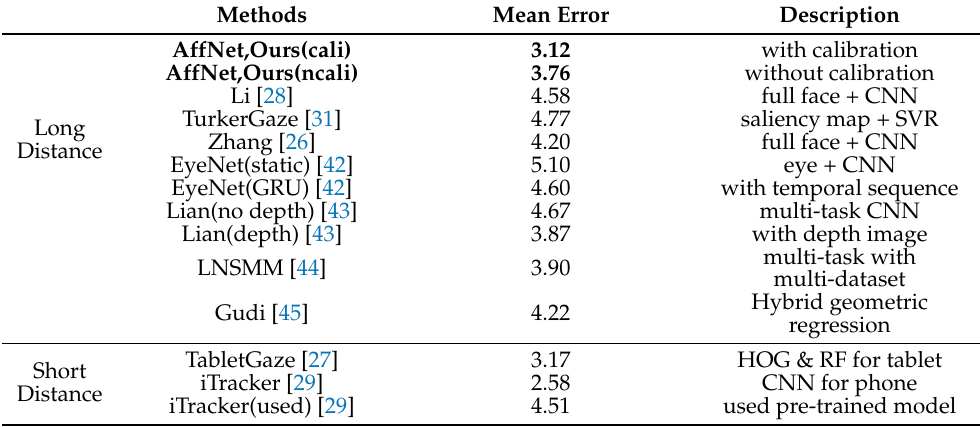
Table 3. Compared to state-of-the-art